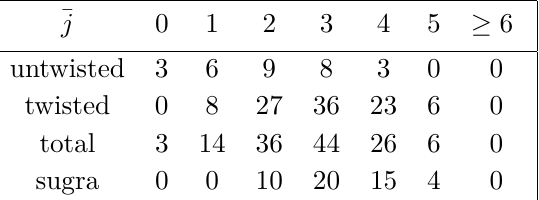
Table 2 . 1/4-BPS spectrum for h = 1 , j = 0